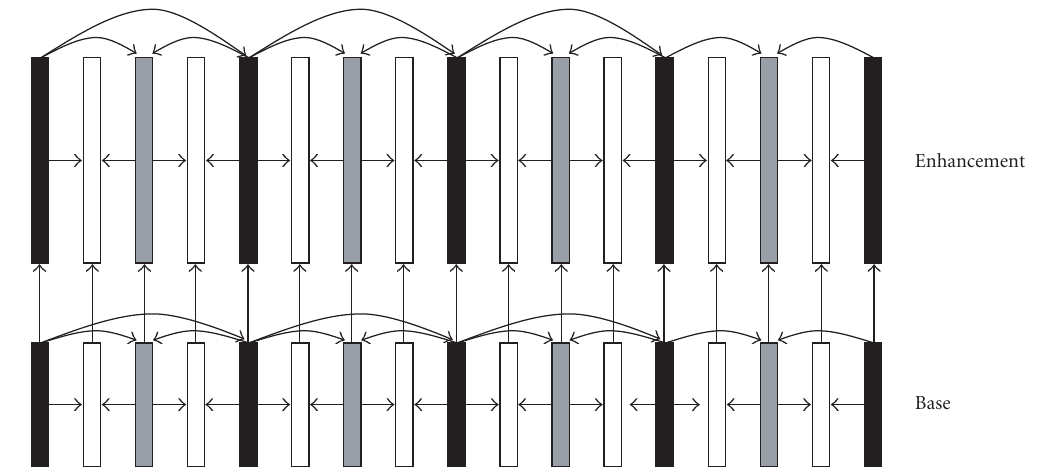
Figure 2: Two-layer spatial scalability intra- and interlayer prediction